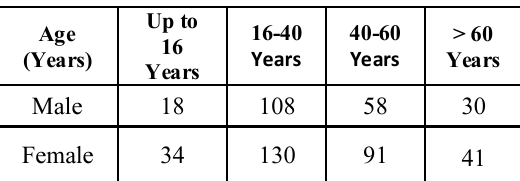
Table 1: Distribution of Patient according